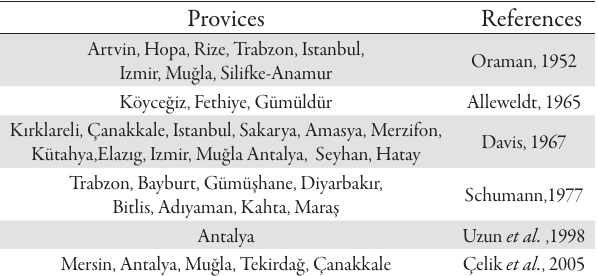
Tab. 1. Distribution of sylvestris by provinces in Turkey